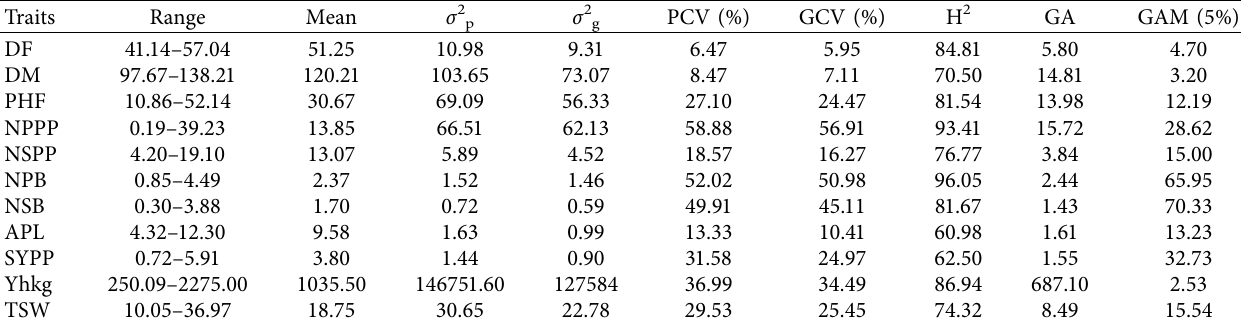
Table 3: Estimates of range, mean, genetic components of variance, heritability, and genetic advance of fenugreek accessions at Haramaya 2016. Traits Range Mean